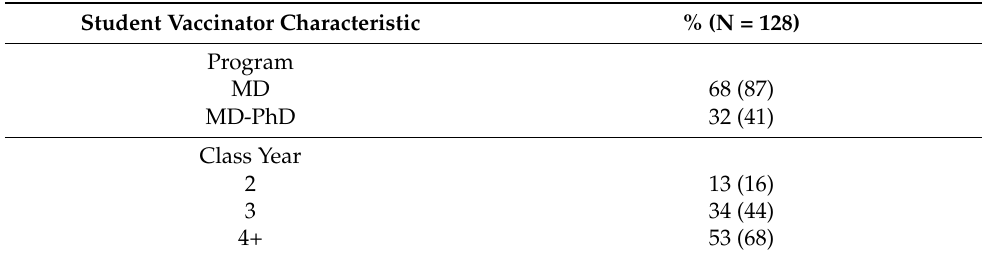
Table 1. Demographics of students certified as